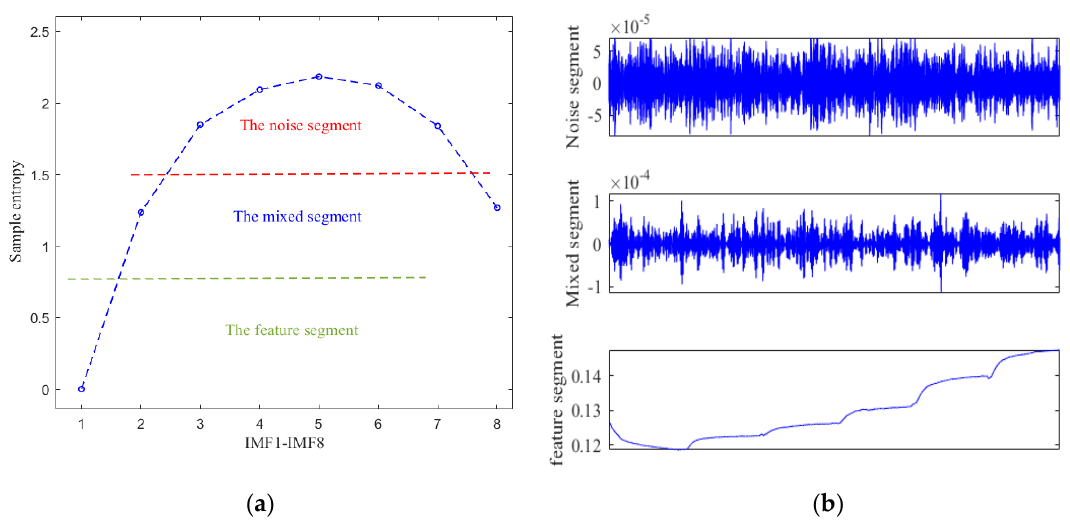
Figure 13. ( a ) Sample entropy of each IMF; ( b ) Classification results of IMFs.